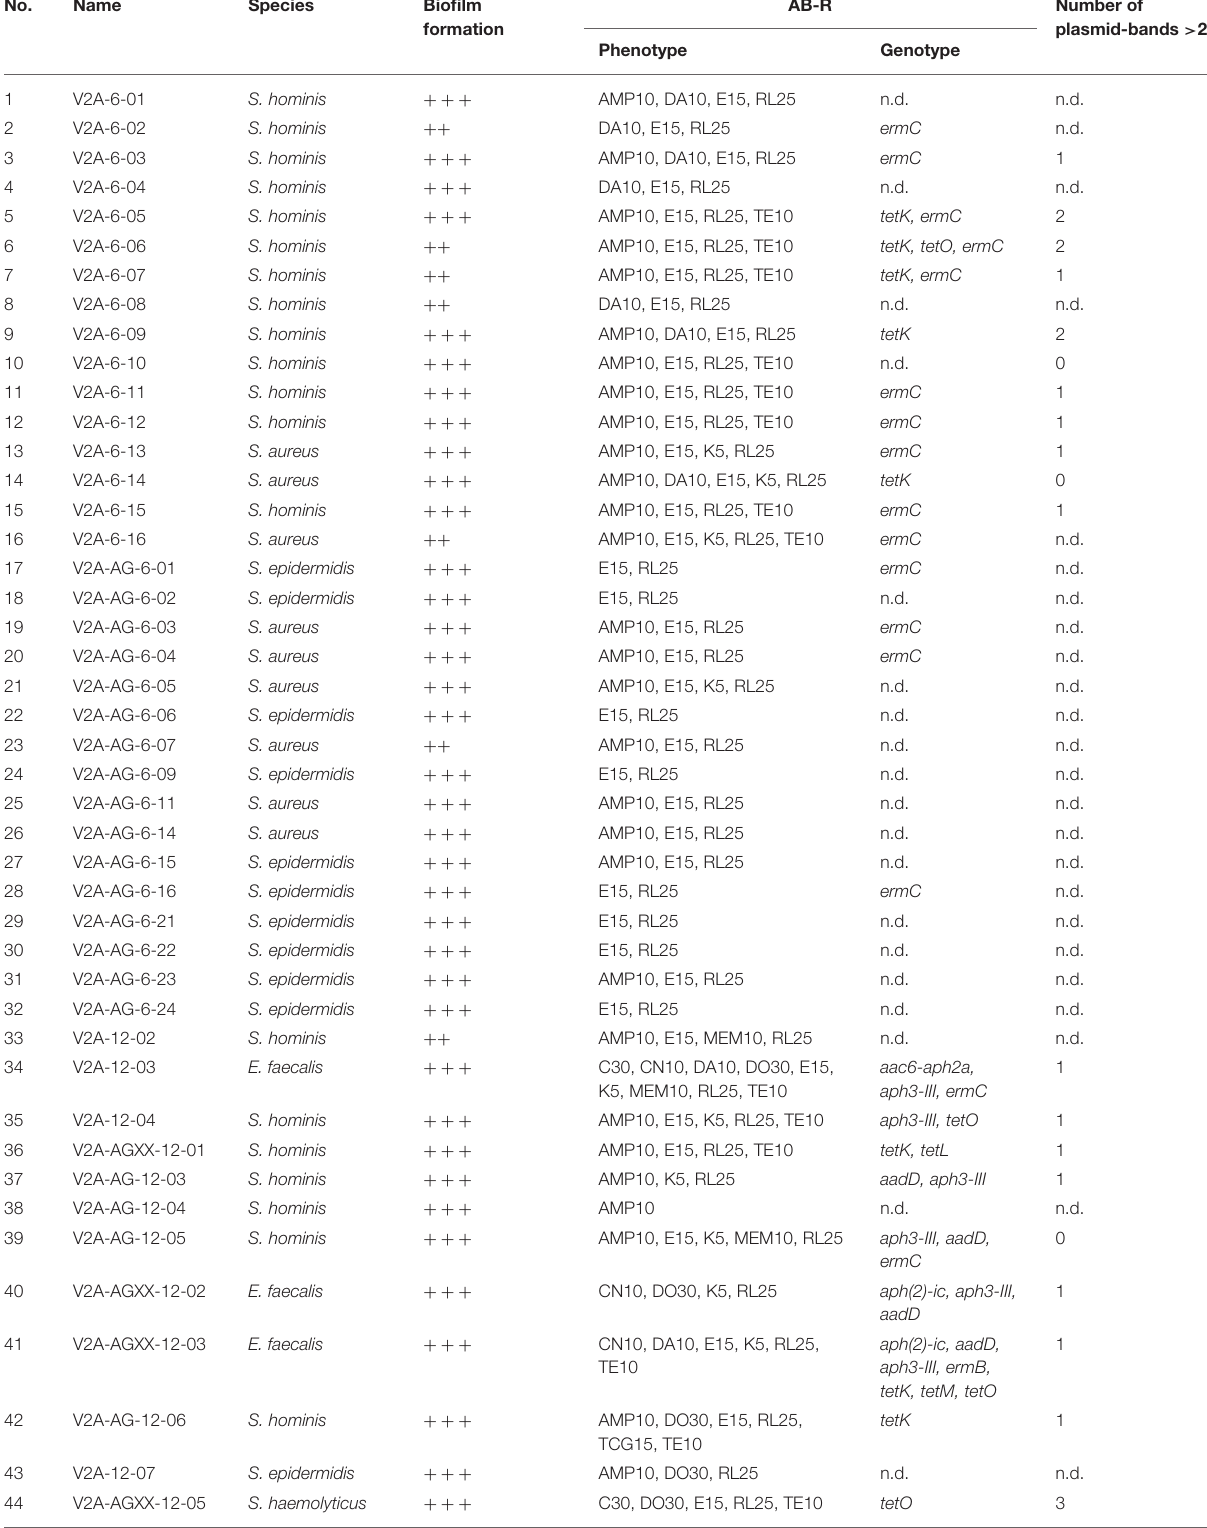
TABLE 5 | Characteristics of all isolates from V2A, V2A-Ag, V2A-AGXX ® after 6, 12, and 19 months.